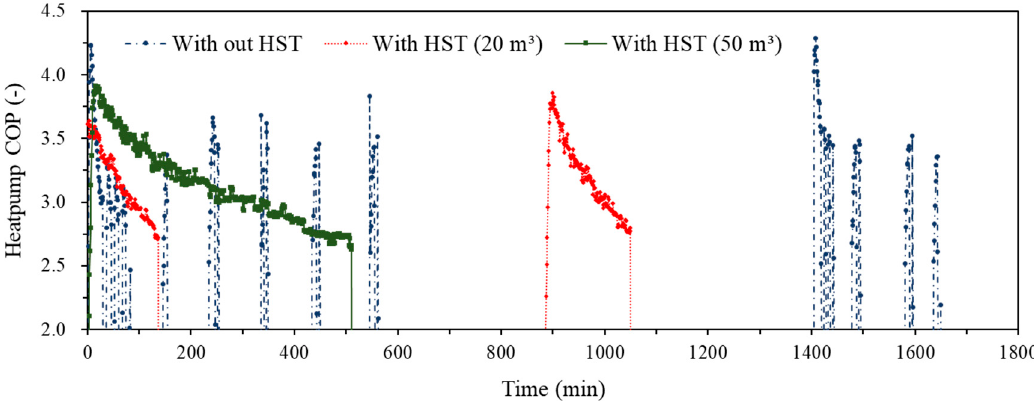
Figure 11. Heat exchange rate (HER) change according to the capacity of HST.